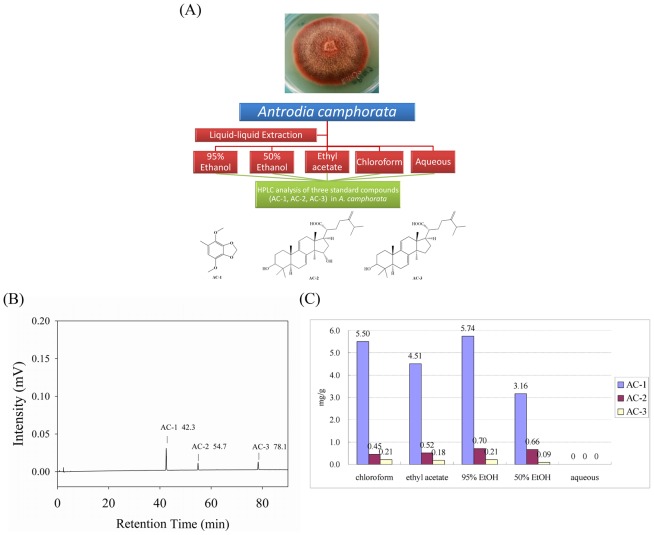
Diagram of separation and chemical analysis of A. camphorata extracts.(A) A schematic representation of a liquid-liquid extraction and bioassay process for A. camphorata. (B) HPLC chromatogram of three reference standards of A. camphorata with corresponding retention times at λ = 245 nm, 4,7-dimethoxy-5-methyl- l,3-benzodioxole (AC-1) (retention time = 42.3 min); dehydrosulphurenic acid (AC-2) (retention time = 54.7 min); dehydroeburicoic acid (AC-3) (retention time = 78.1 min). Separation was performed in a Merck (50995) LiChrospher RP-18 column (4.6 mm×250 mm, 5 µm), at a flow rate of 1 mL/min. The mobile phase consisted of A (water) and B (100% acetonitrile): 0–90 min, 100–0% A and 0–100% B.(C) Quantitative analysis of three standards in five A. camphorate extracts: chloroform (CHCl3), ethyl acetate (EA), 95% ethanol (EtOH), 50% ethanol (EtOH), and H2O.